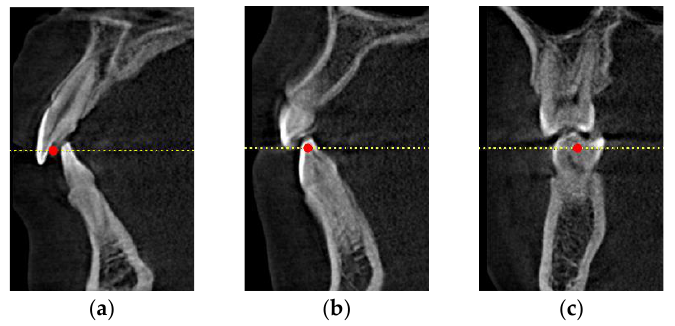
Figure 5. Images of tooth sections in different locations. ( a ) Incisor section. ( b ) Canine section. ( c ) Molar section.